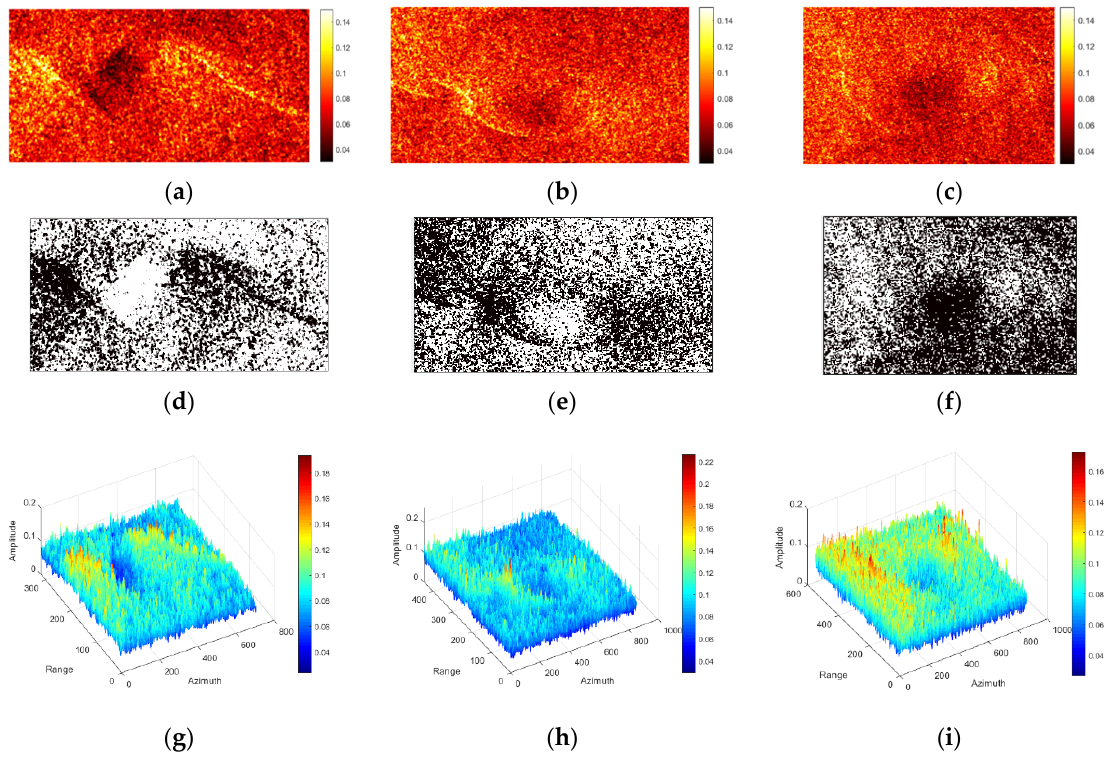
Figure 10. Comparison of “white” eddy ( E-1 , E-2 , and E-3 ) detection results in the CP feature c 42( Pd ) image. ( a – c ) Slices of the eddies ( E-1 , E-2 , and E-3 ) in the feature image. ( d – f ) Eddy detection results based on the k-means clustering algorithm. ( g – i ) Three-dimensional structure maps of the eddies ( E-1 , E-2 , and E-3 , respectively) in the feature images. Table 5. “White” eddies detection accuracy.